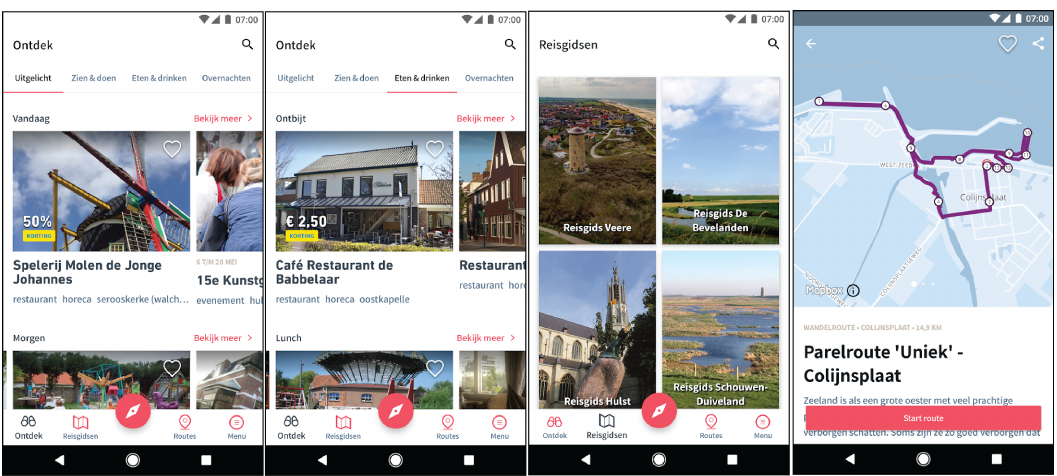
Figure 2. Screenshots of the Zeeland mobile application.